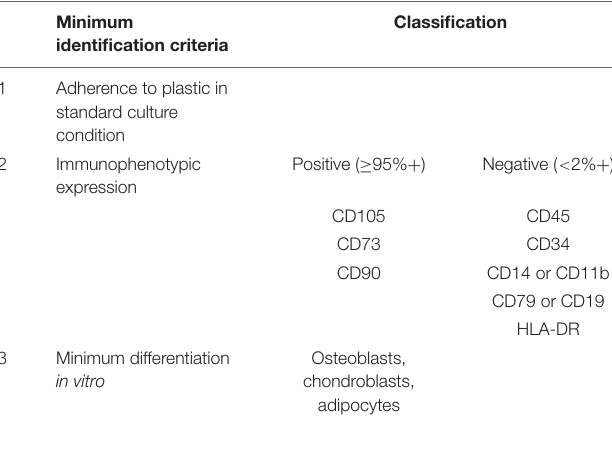
TABLE 1 | Criteria to identify MSCs (Dominici et al.,